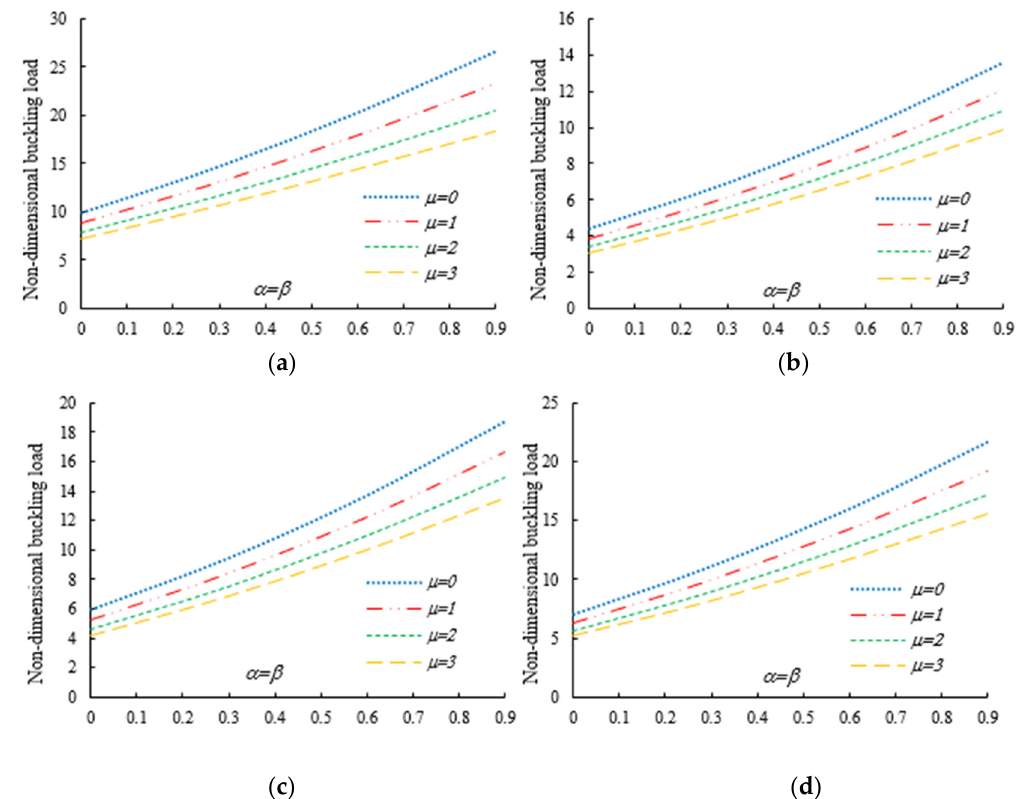
Figure 3. Variation in the flexural–torsional buckling load ( P nor ) of I-tapered nanobeams with varying tapering and non- locality parameters—Figure 2. Effect of the axial load eccentricity, material graduation and tapering parameter on the ( ) P for simply supported thin-walled nanobeams subjected to a constant compressive load normalized buckling load nor with two different nonlocal parameters: ( a ) Homogeneous (Alumina) ; ( b )